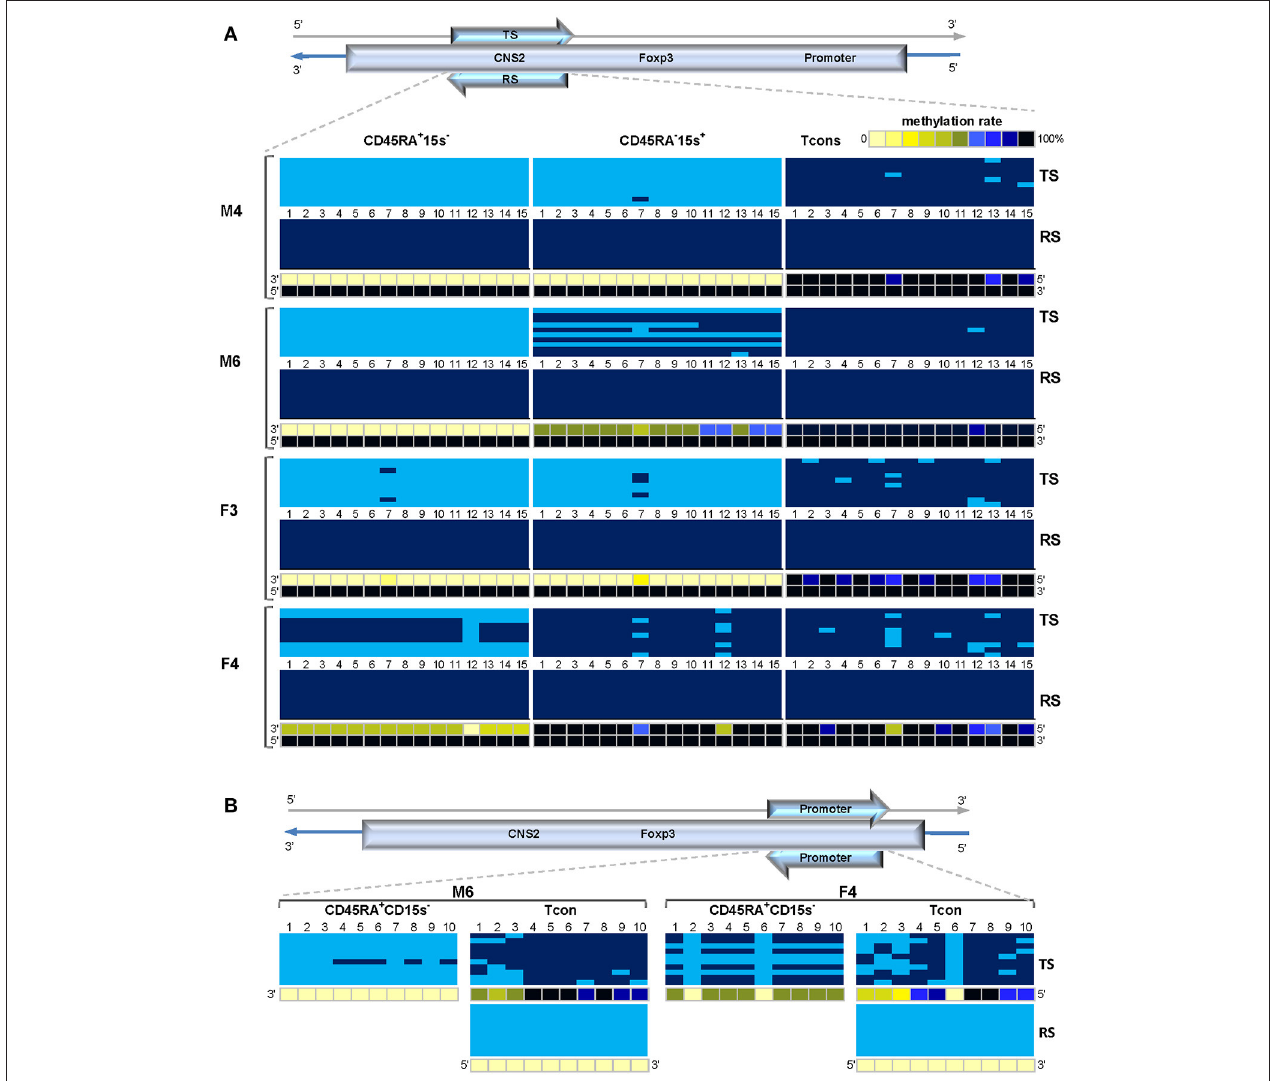
FIGURE 8 | Strand-specific methylation bias within the FOXP3 TSDR and promoter regions. Treg TSDR region in some donors is characterized by a complete methylation of the coding (reverse) strand and a significant demethylation of its complement template (top) strand. (A) Methylation patterns of the top (TS) and reverse (RS) strands within FOXP3 TSDR in CD45RA + CD15s − , CD45RA − CD15s + and Tcon cells of “unconventional” donors M4, M6, F3, and F4. CpGs 1-15 are numbered relative to the 5 ′ -3 ′ direction of the coding (reverse) strand. (B) . Methylation patterns of the TS and RS within FOXP3 promoter in CD45RA + CD15s − and Tcon cells of “unconventional” donors M6 and F4. CpGs 1-10 are numbered relative to the 5 ′ -3 ′ direction of the coding strand (RS). Each horizontal line represents DNA from one cell with unmodified C in light blue and m C in dark blue. Methylation percentage for each CpG site was calculated based on the number of m Cs in a total of 10 and summarized in panels below. See also Supplementary Figure 2